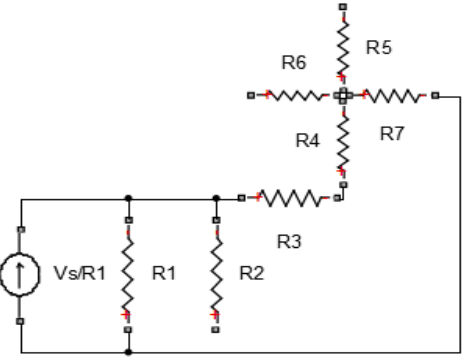
Figure 14. Transformed example resistor network.